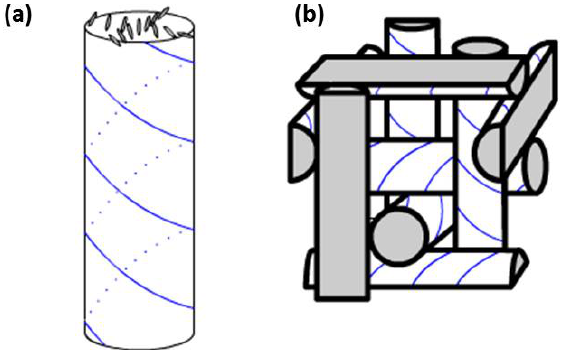
Figure 9. ( a ) Double twist cylinder structure and ( b ) cubic lattice of a blue